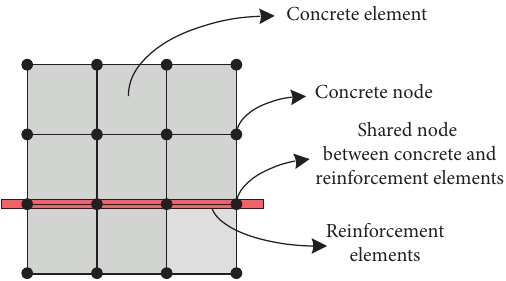
Figure 1: Shared common nodes between concrete solid element and reinforcement beam element (discrete model).